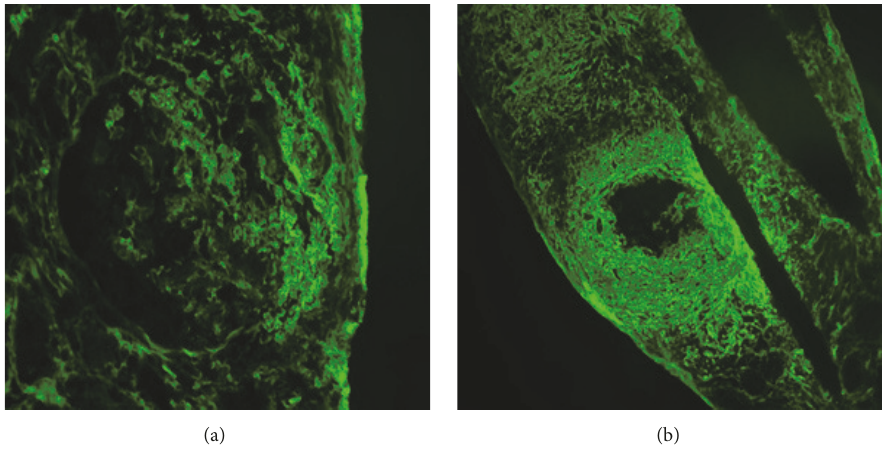
Figure 4: Fibrinogen staining shows cellular crescents (a) and necrosis of an artery